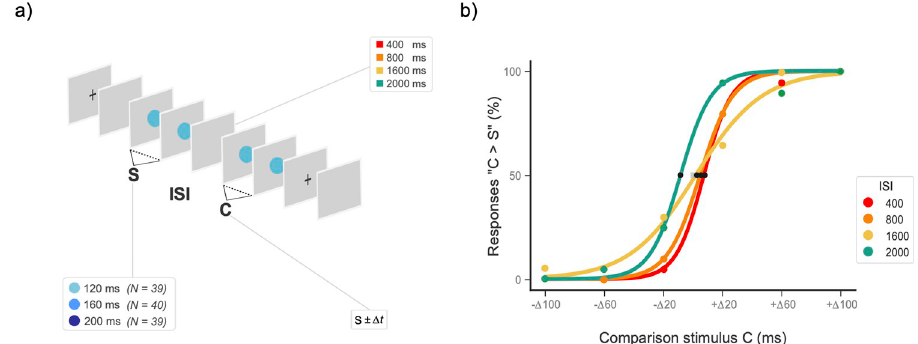
Fig 1. Experimental paradigm and response model. a) Sequence of events in the 2IFC temporal-discrimination task. To test whether rhythmic attention plays a role in time distortions, we parametrized the duration of S into three separate participant groups: 120-ms S, 160-ms S and 200-ms S, which correspond to attentive frequencies of 8.33, 6.25 and 5 Hz, respectively. For each S duration, the inter-stimulus interval (ISI) was parametrized into four levels: 400, 800, 1600, and 2000 ms. In each trial, participants determined whether the standard (S) or the comparison event (C) lasted longer. b) Example of response model fit for one participant in each ISI level of a 120-ms S: The six C durations are plotted on the x-axis and the probability of responding “C longer than S” on the y-axis. Black dots interpolated at the 50% value on the y-axis correspond to the points of subjective equality (PSE) for each condition. The just noticeable difference (JND) is obtained from the slope β of each curve.